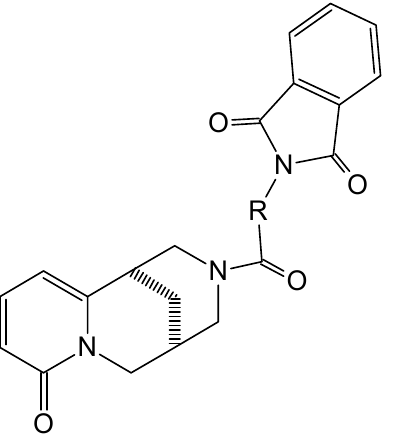
Figure 1. The structures of studied compounds. R = –CH 2 – ( 3A , N -[glycine-( N -phtaloyl)]cytisine),